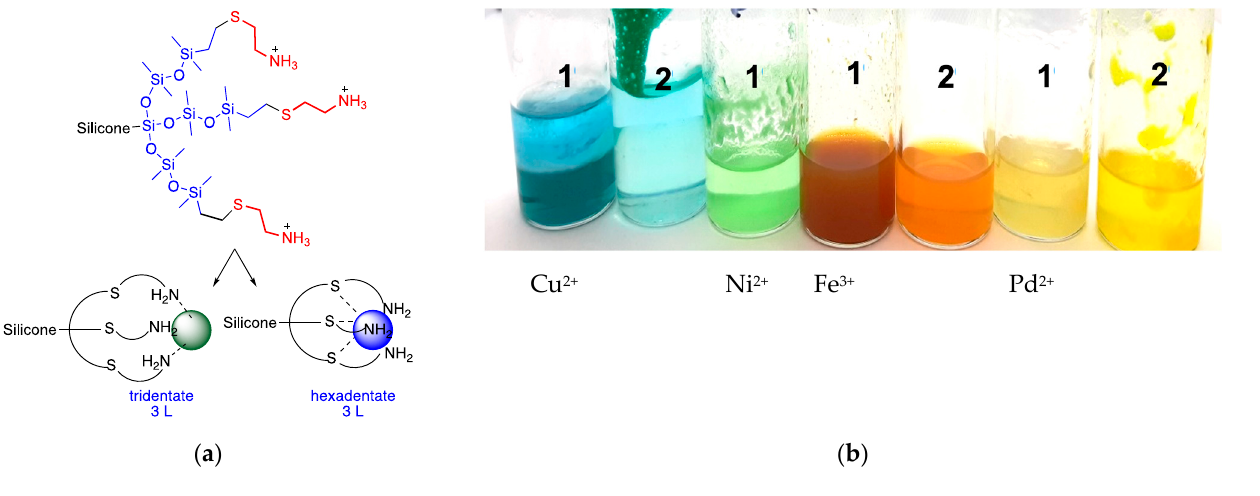
Figure 3. ( a ) Possible tri/hexadentate binding motifs to a tricysteamine chelator. ( b ) Chelation of amine and COOH ligands (1 = N7-6 or 2 = HO7-6 in DCM) to various metals salts in water (upper layer).